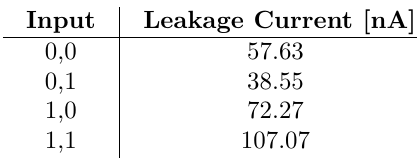
Table 1: Input-dependent leakage current of a 2-input NAND gate in 45 nm technology taken from [AO14].